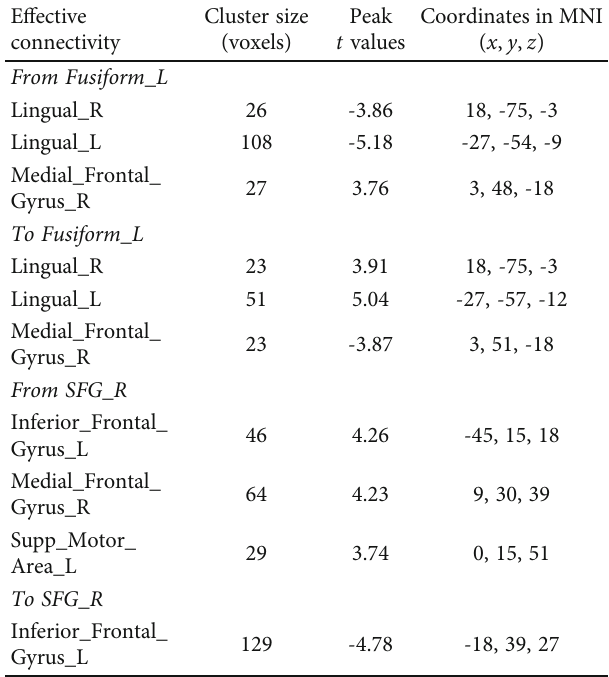
Table 3: Brain regions with signi fi cant group di ff erences in EC. E ff